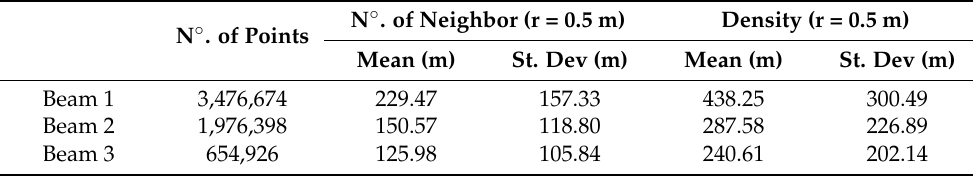
Table 9. Density and point number statistics of different L1 signal returns. N ◦ . of